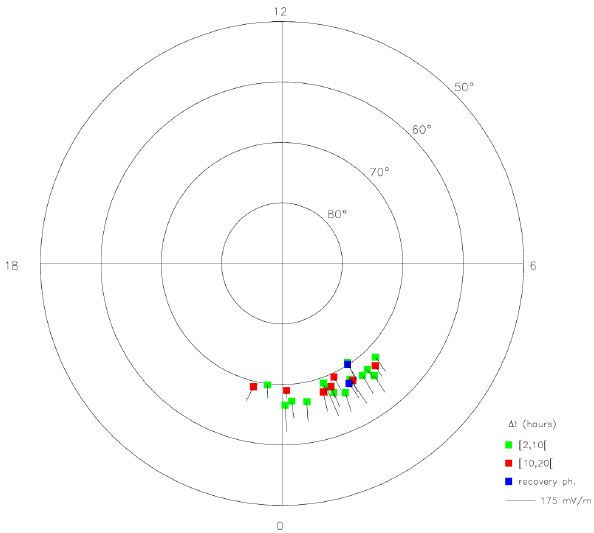
Fig. 4. Polar plot in CGLat and MLT coordinates of the location of the ASAID events (squares). The black segments indicate the amplitude and the orientation of the associated electric field peaks. The parameter 1t is color coded.